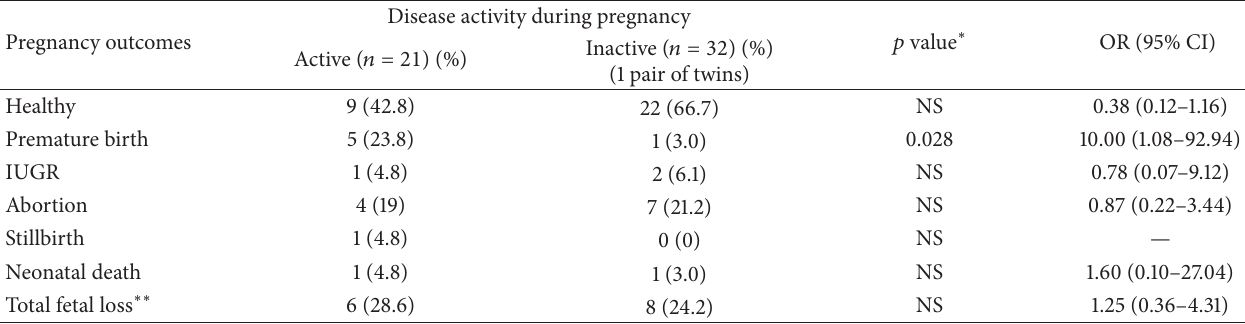
Table 2: Pregnancy outcomes in active and inactive